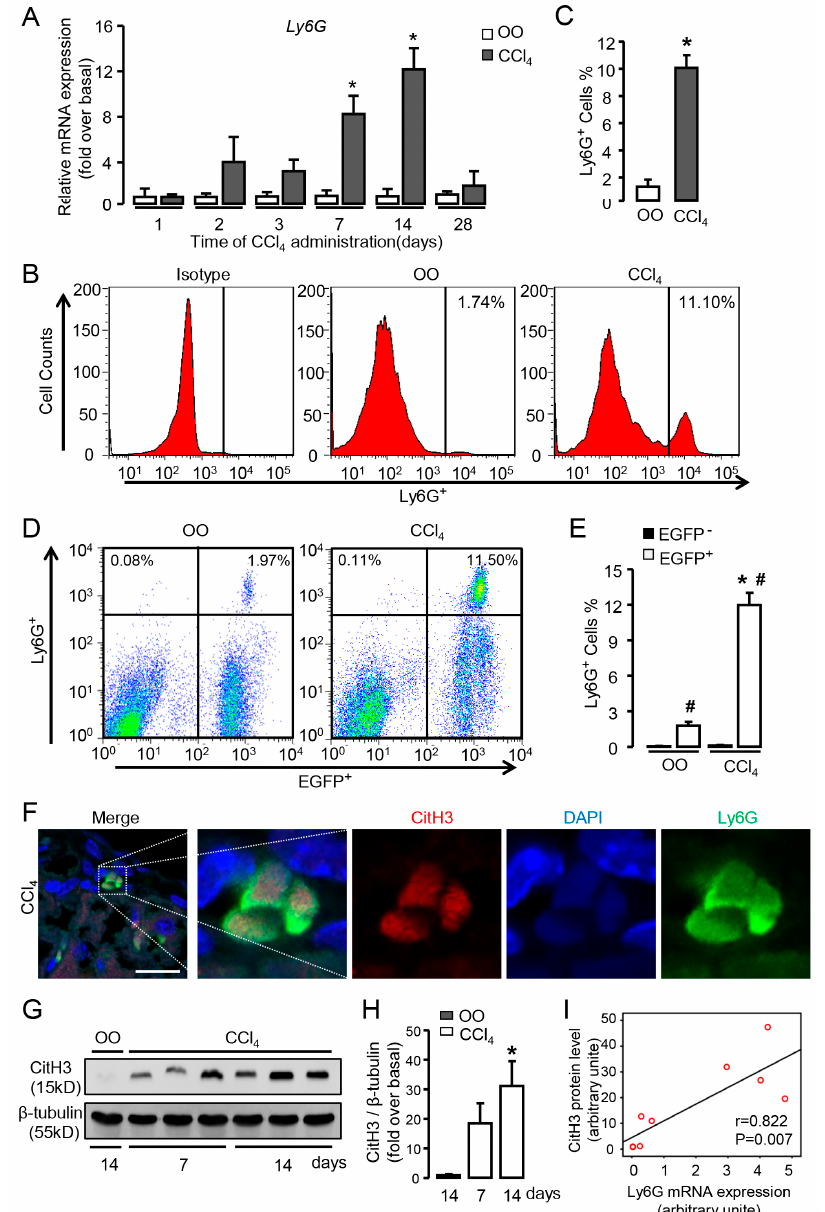
Figure 1. Numerous neutrophils are recruited and activated in the liver of carbon tetrachloride (CCl 4 )-treated mice. ( A ) The mRNA expression of neutrophil marker Ly6G was examined by qRT-PCR in the injured liver of CCl 4 mice. ( B , C ) Representative FACS plots and quantification for total neutrophils (Ly6G + ). ( D , E ) Representative FACS plots and quantification for neutrophils of BM origin (Ly6G + EGFP + ) and non-BM origin (Ly6G + EGFP - ). ( F ) Immunofluorescent staining for CitH3 in the liver of CCl 4 -treated mice. Scale bars, 20 µm. ( G , H ) CitH3 expression in the injured liver was examined by Western blot. ( I ) The correlation between CitH3 protein levels and Ly6G mRNA expression in liver tissue. Data are presented as the mean ± SEM. N = 6 per group. * P < 0.05 vs. control. # P < 0.05 vs. EGFP - neutrophils with the same treatment.